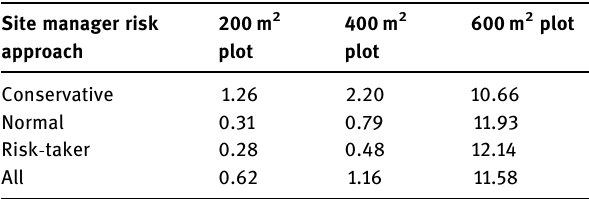
Table 10: Average frequency of selecting each soil strengthening variant over the course of the project by designer risk approach Designer risk approach